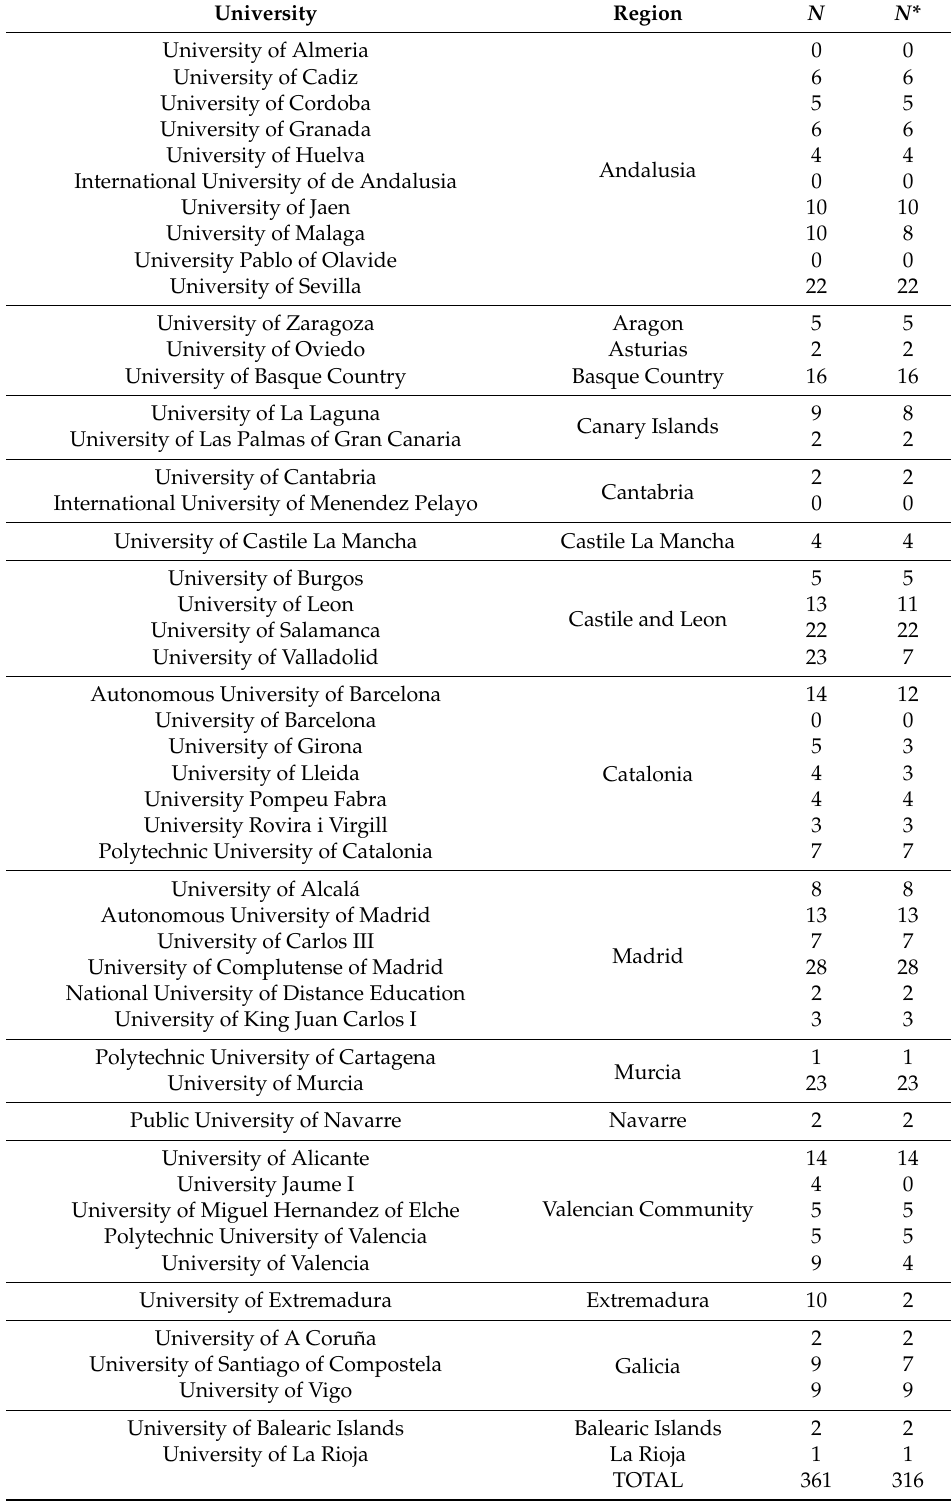
Table 1. Number and provenance of the procedures of the study